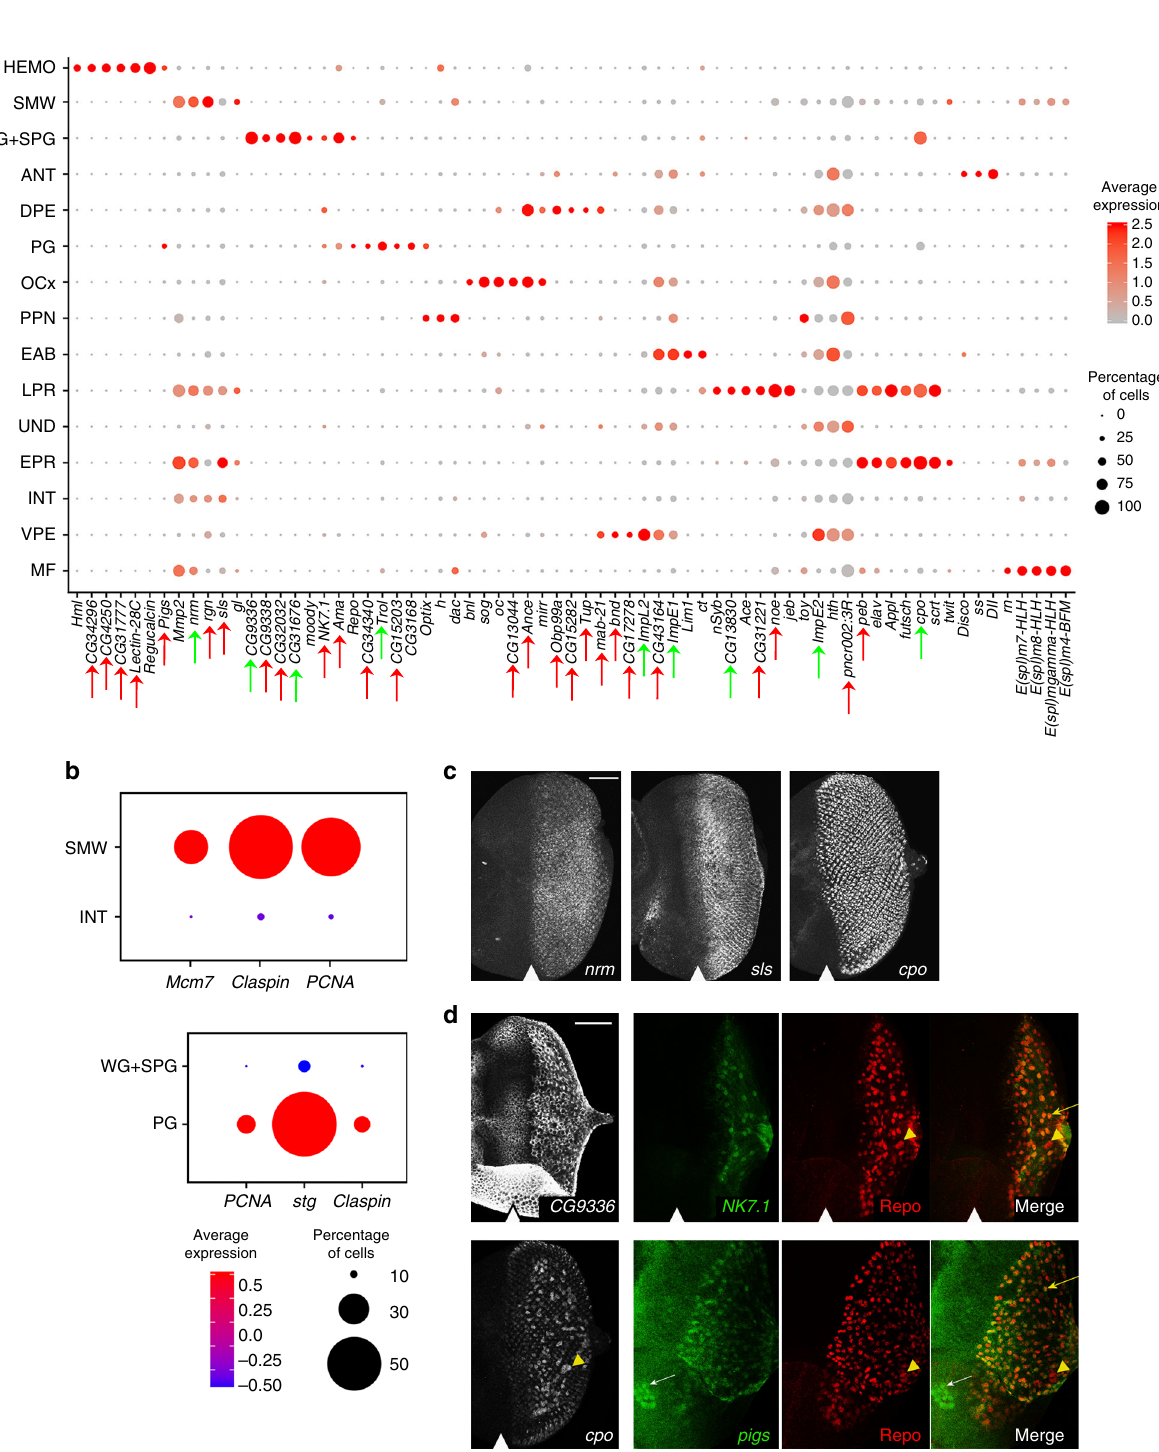
Fig. 3 Single-cell RNA-seq identi fi es cell-speci fi c markers. a Dot plot of top markers for all populations. Red arrows point at previously unreported eye cell- type markers. Green arrows indicate genes previously studied in the eye that were not assigned to a speci fi c cell type. The genes without arrows are known markers used to assign cell populations. b LacZ enhancer traps for posterior candidate markers neuromusculin ( nrm ), sallimus ( sls , also known as kettin ) and photoreceptor marker couch potato ( cpo ). c Dot plots, top panel shows interommatidial populations INT and SMW, showing expression of cell-cycle genes exclusively in SMW subpopulation. Bottom panel shows glial cell populations PG and WG + SPG showing expression of cell-cycle genes exclusively in PG. The scale bar is 50 µ m. d Wrapping glia markers CG9336 and NK7.1 of and their expression as revealed by FISH ( CG9336 ) and a GFP reporter for NK7.1 (green). Repo (red) is a glial marker. Merge image marks cells co-expressing NK7.1 and Repo, also shown with yellow arrow. Markers of PG, cpo and pigs are revealed by LacZ enhancer trap and GFP reporter, respectively. SPG are indicated by a yellow arrowhead, overlap of Repo and pigs shown with yellow arrow. The scale bar is 50 µ m. The position of the MF is shown by white